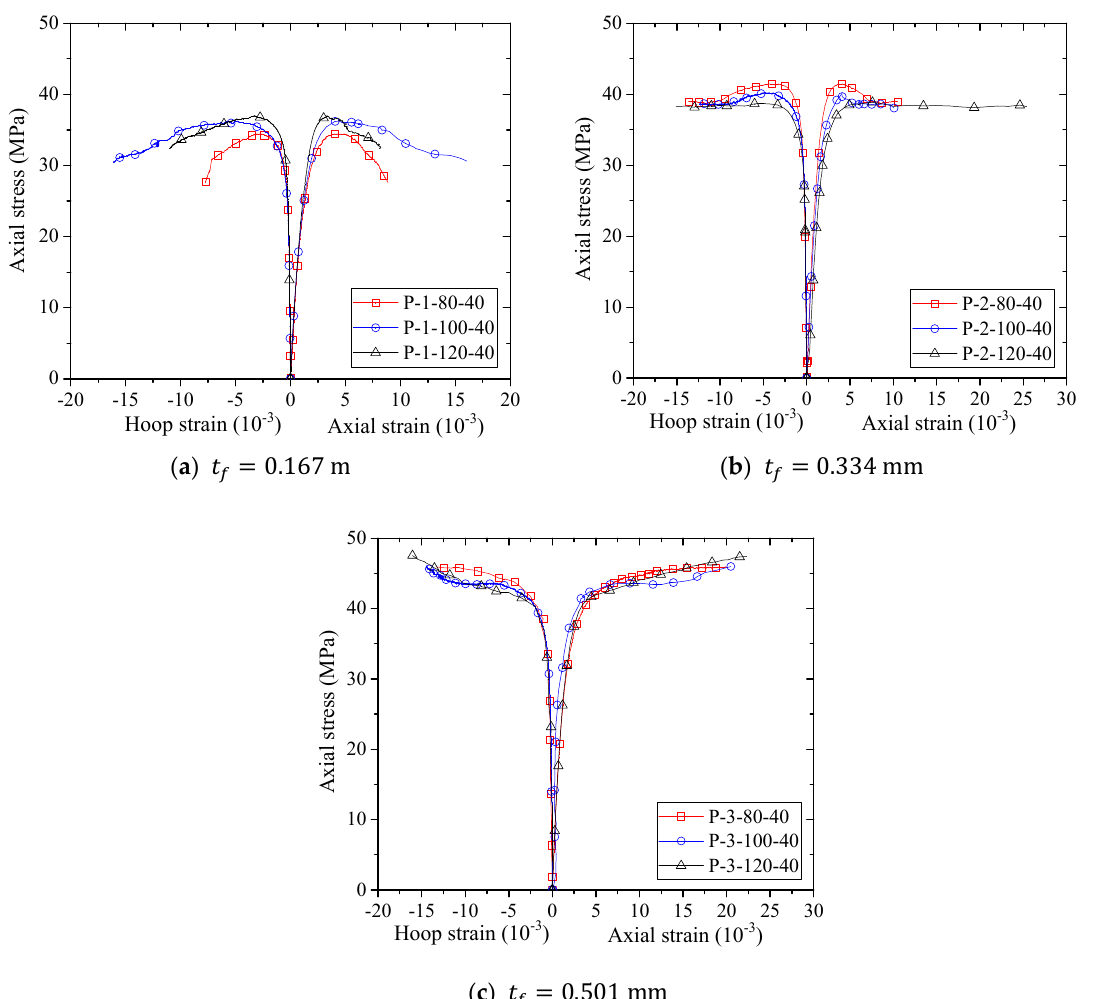
Figure 11. Stress–strain curves of concrete in specimens with different FRP strip thicknesses. The stress–strain responses of the specimens with an identical FRP volumetric ratio ( ρ f ) and the specimens with an identical FRP confinement efficiency ratio ( ρ f k v ) are reported in Figure 12. In this paper, the FRP confinement efficiency ratio is referred to as the product of the FRP